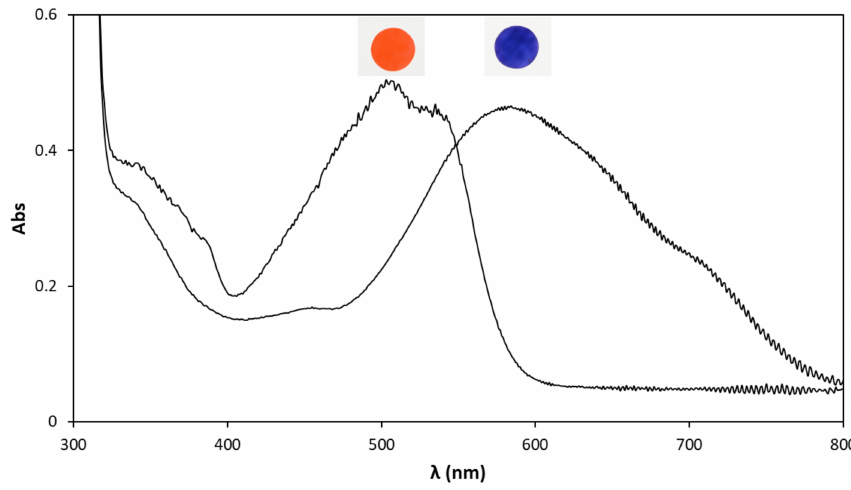
Figure 3. UV/vis absorption spectra and digital photographic images of the Congo Red ink film in ambient air (red, λ max = 586 nm), and after being placed in contact with an acidic (HCl) vapour (blue, λ max = 505